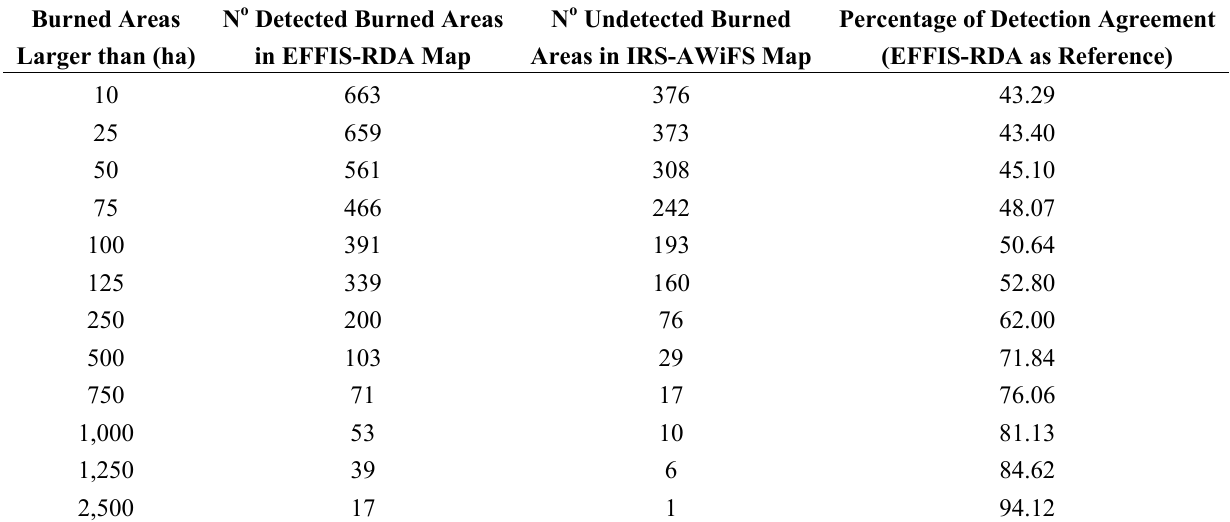
Table 2. Number of burned areas detected in IRS-AWiFS-based burned scar map and MODIS-based EFFIS Rapid Damage Assessment (EFFIS-RDA).